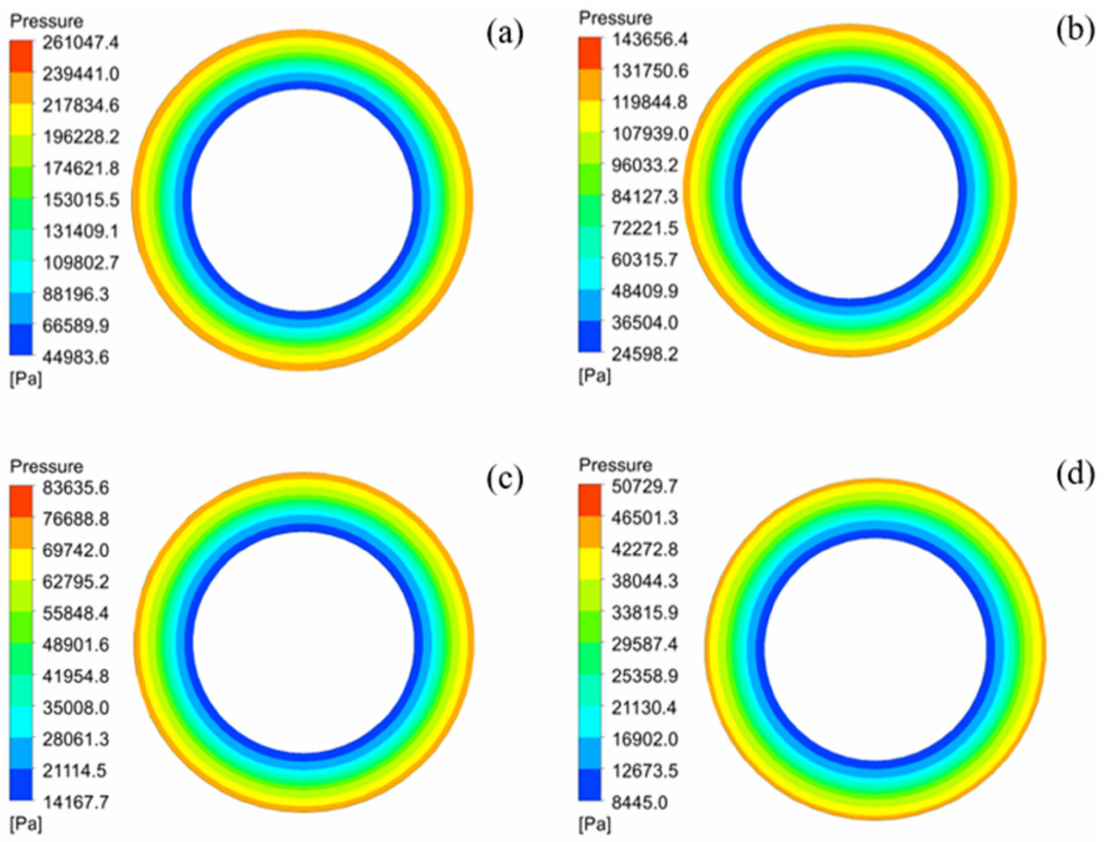
Figure 7. Distribution of flow pressure on the surface of PCMT with different porosity: ( a ) 30%, ( b ) 35%, ( c ) 40% and ( d )